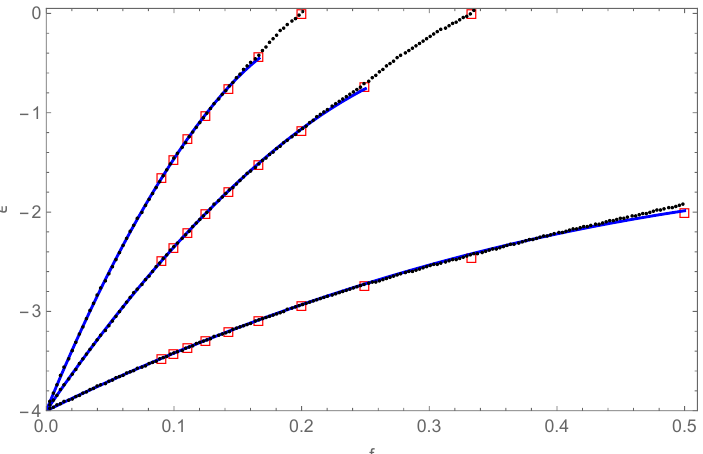
( f ) obtained from the Roth-Gao-Niu rule (blue line) fits Figure 7: The position of the LLs ε GN n very well the field dependence of the average energy of the Landau bands (black dots) obtained from the Hofstadter spectrum. The position of the middle of the bands when f = 1 / q is also ( n ) = 1 plotted (red squares). These fits work perfectly well up to the maximal flux f max 2 ( n + 1 ) (where n = 0,1,2, ··· is the Landau index) and start to deviate beyond